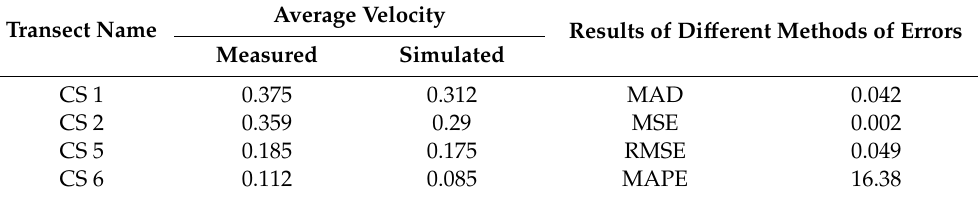
Table 6. Comparisons between measured and simulated average flow